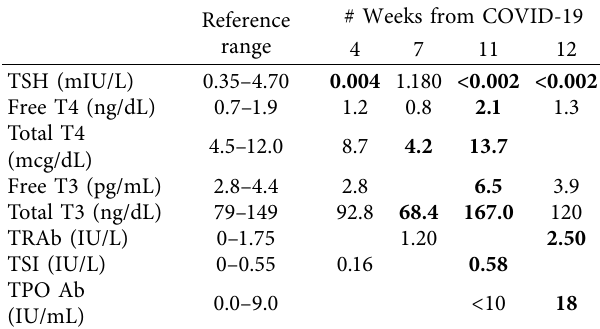
Table 1: Laboratory thyroid function